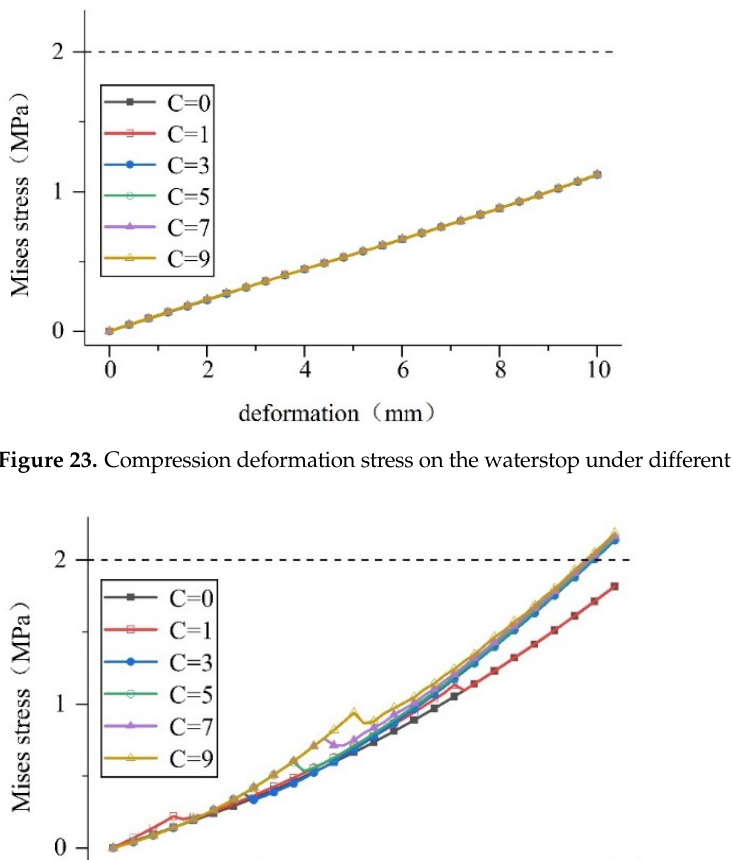
Figure 22. Tensile deformation stress on the waterstop under different bonding force conditions.